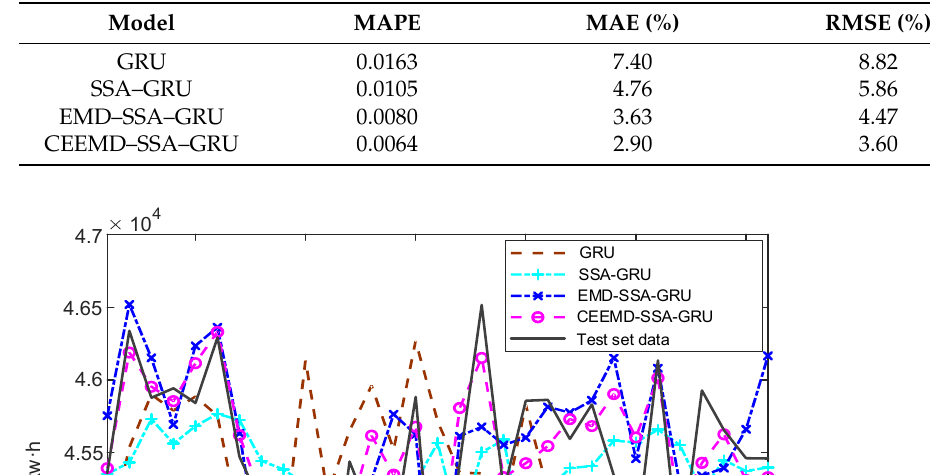
Table 6. Prediction error evaluation index.